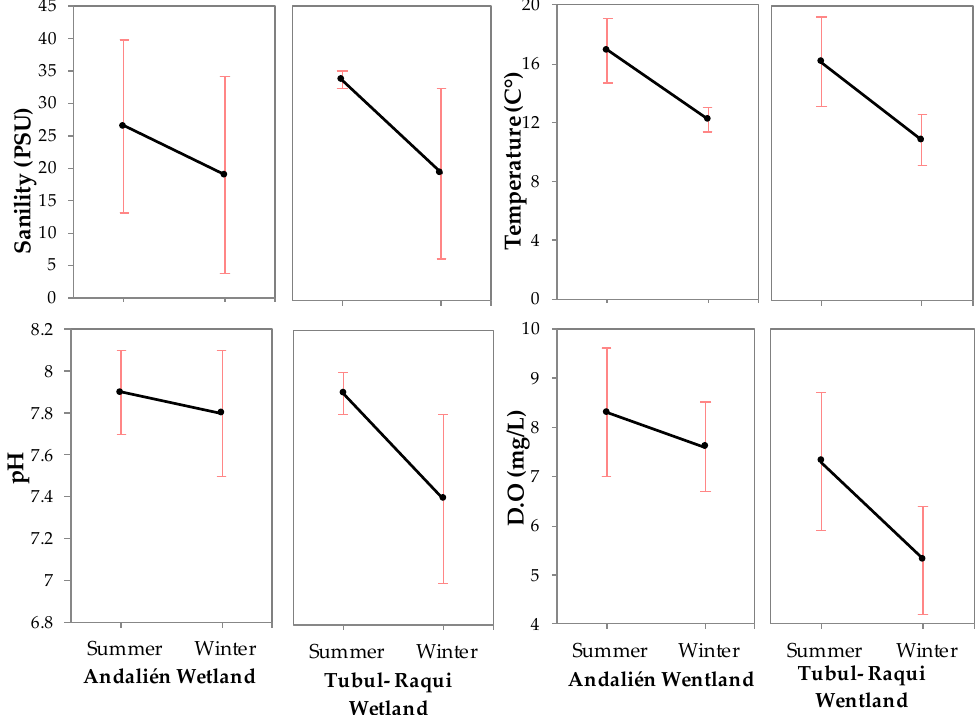
Figure 3. Graph of the model effects (Station × Wetlands effect plot).